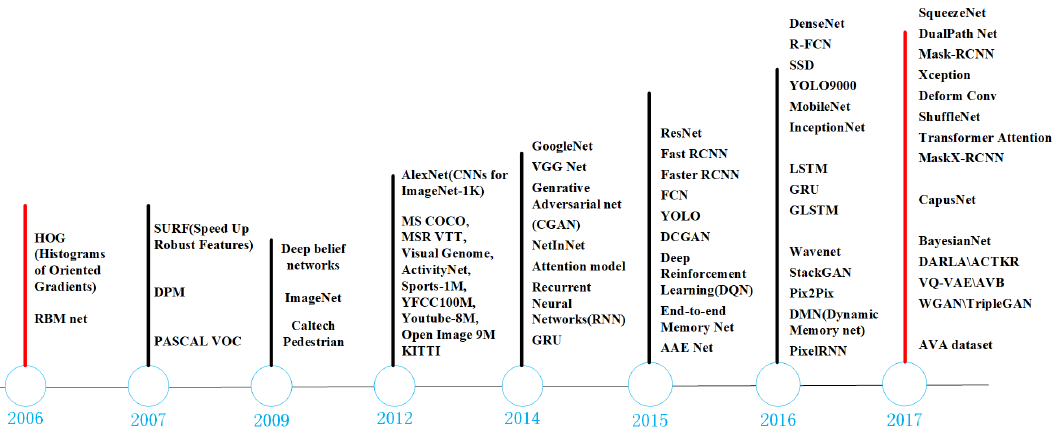
Figure 9. Some famous events revealed the heat of deep learning